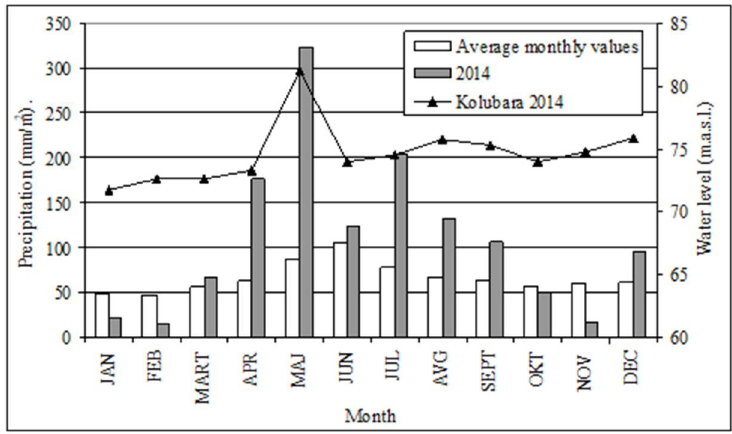
Figure 3. Histograms of monthly precipitation averages for the period 1961–2013 vs. 2014 (weather station at Valjevo) and monthly average stages of the Kolubara River (gauging station at Draževac).